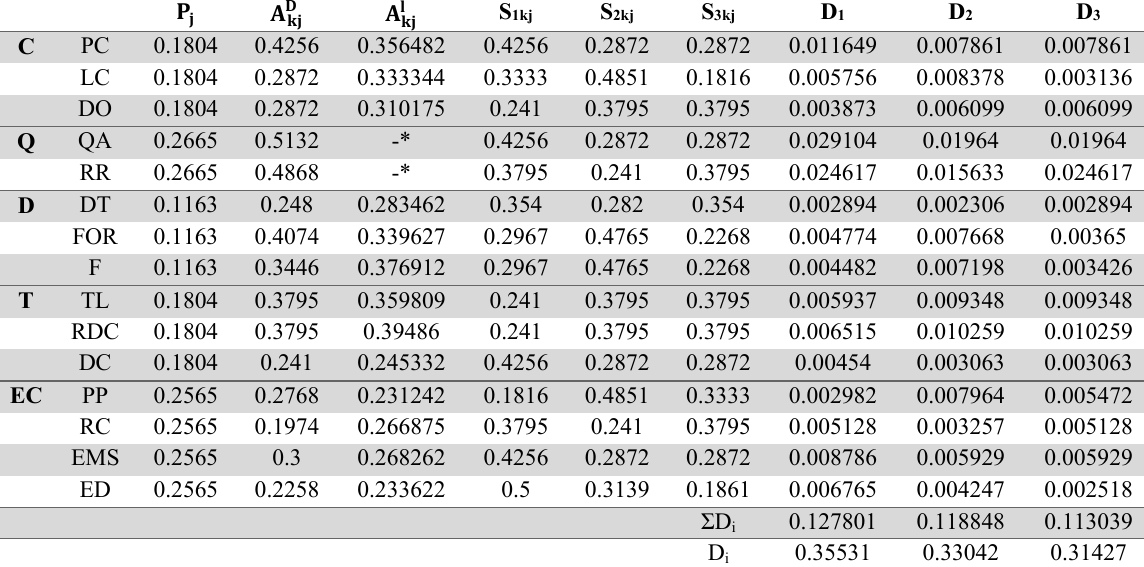
Calculation of the utility index for